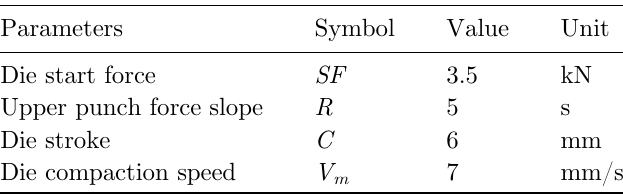
Table 2. Regulation parameters of the cycle press, SF , R , C , V m